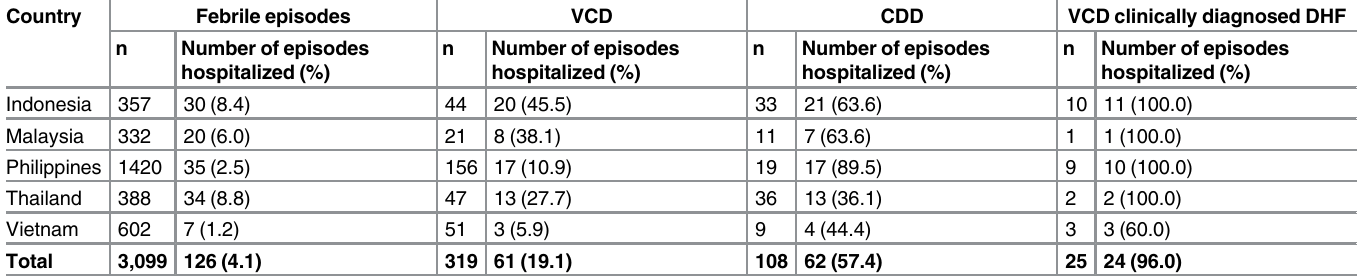
Table 4. Number of episodes and hospitalizations in CYD14 study control subjects experiencing acute fever, VCD, CDD, or VCD clinically diag- nosed DHF.